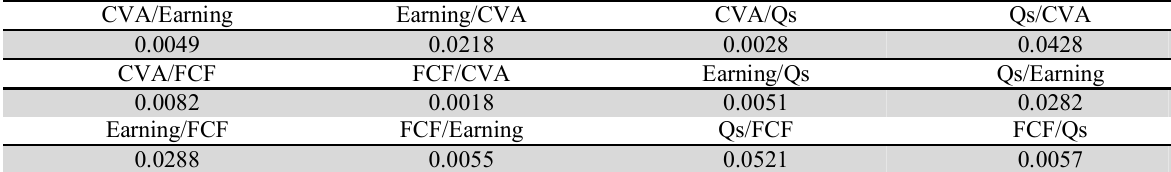
The summary of incremental values of each pairs of